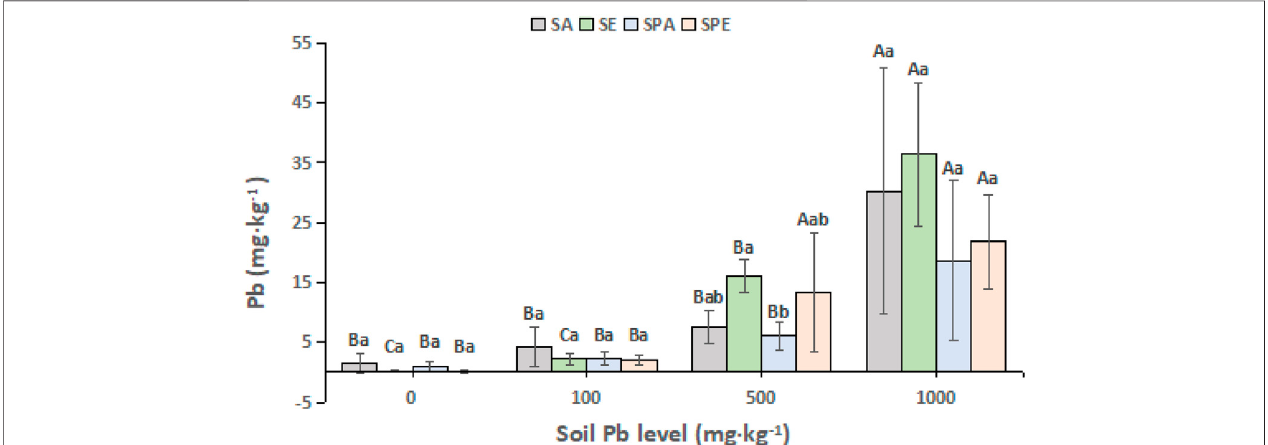
FIGURE 1 | Pb accumulation in the two earthworm species, Amynthas aspergillum and Eisenia fetida , under different Pb contamination conditions. *SA: A. aspergillum was inoculated, SE: E. fetida was inoculated, SPA: Brassica campestris was grown and A. aspergillum was inoculated, SPE: B. campestris was grown and E. fetida was inoculated. Different uppercase letters indicate signi fi cant differences for a same treatment between different soil Pb levels at p < 0.05; different lowercase letters indicate signi fi cant differences between treatments for a same soil Pb level at p < 0.05.